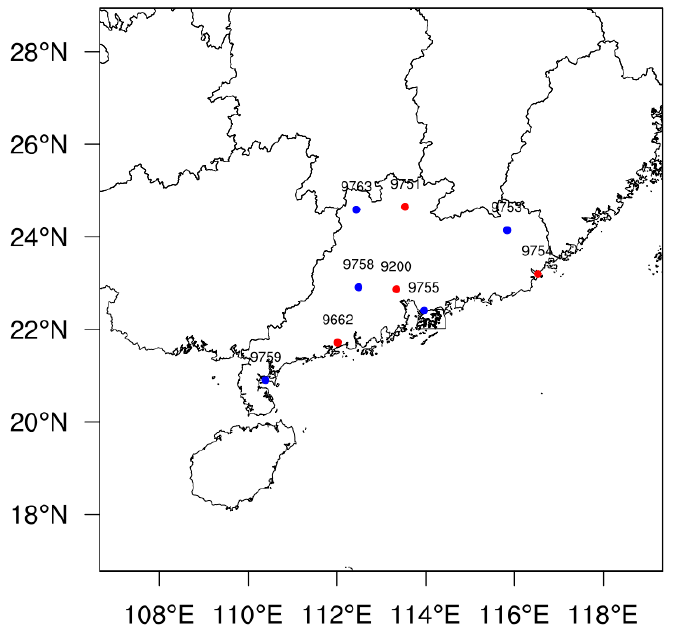
Figure 1. Distribution of nine Doppler weather radars in Guangdong: Guangzhou (9200), Yangjiang (9662), Shaoguan (9751), Meizhou (9753), Shantou (9754), Shenzhen (9755), Zhaoqing (9758), Zhan- jiang (9759) and Lianzhou (9763) radar stations. Red dots represent radars used to identify MVs.